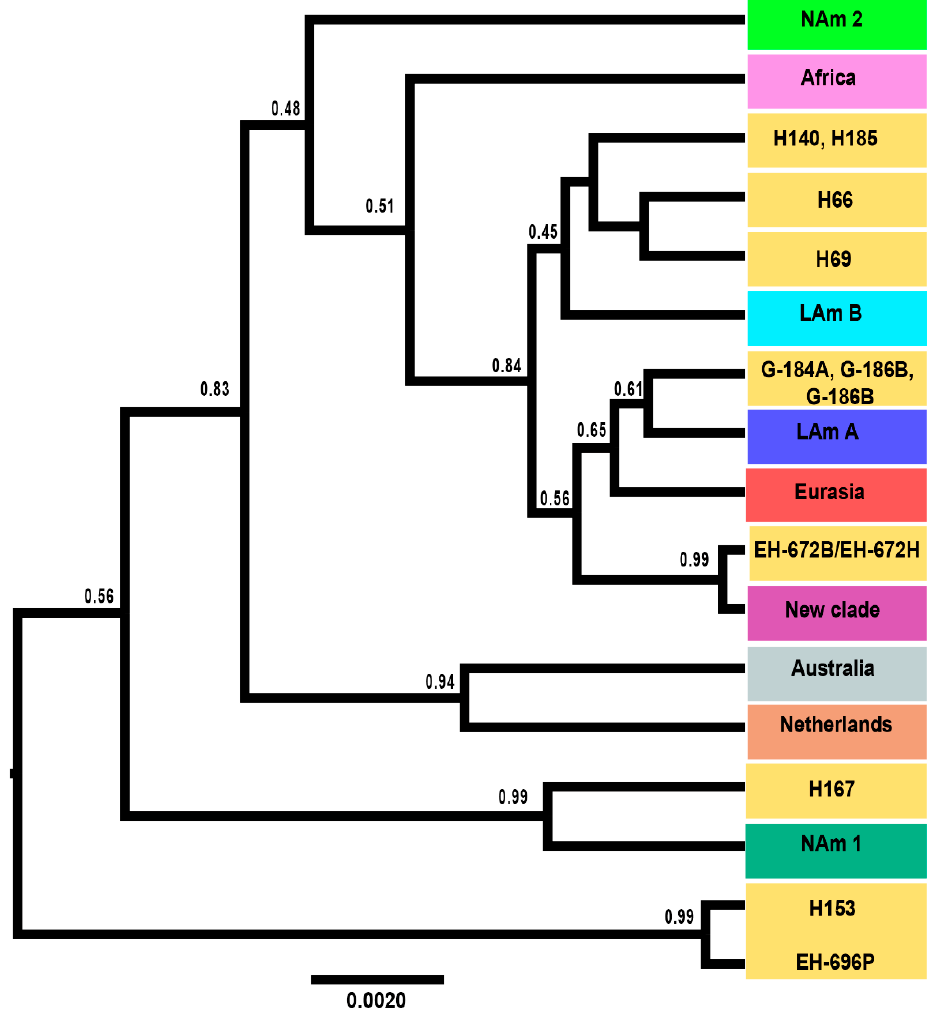
Figure 2. Species tree generated by coalescent-based species delimitation methods of the H. capsulatum complex. Maximum- clade-credibility tree of the concatenated gene fragments arf , H-anti , ole1 , and tub1 was selected from the *BEAST analysis, using a strict molecular clock (see Materials and Methods). The values of pp are indicated on their corresponding branches of the tree